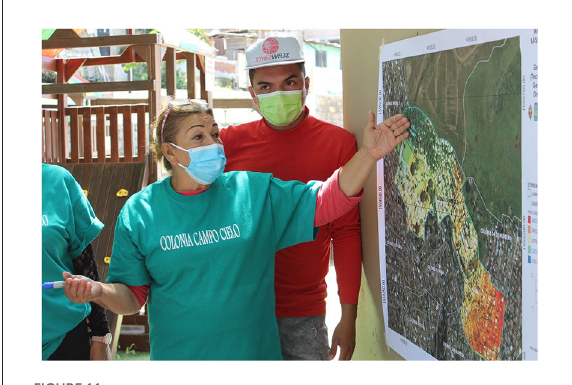
FIGURE11 GOAL supported risk awareness in neighborhoods through collaborative processes, like the public group discussion of the hazard map shown here in July 2021 in the Campo Cielo community in Tegucigalpa. Credit: GOAL,